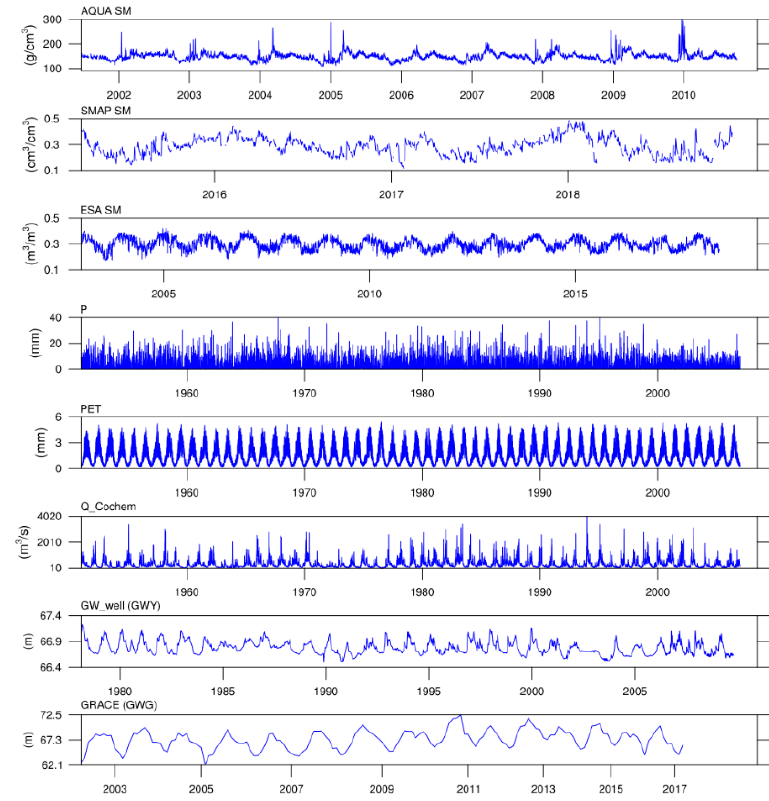
Figure 2. Catchment scale time series of remotely sensed soil moisture (RS-SM) products (AQUA, soil moisture active passive (SMAP) and ESA), hydrologic model inputs (P and PET), and discharge data (Q) from Cochem Gauge, GW well measurements (GWY) and Gravity Recovery and Climate Experiment (GRACE) groundwater storage data (GWG), respectively .